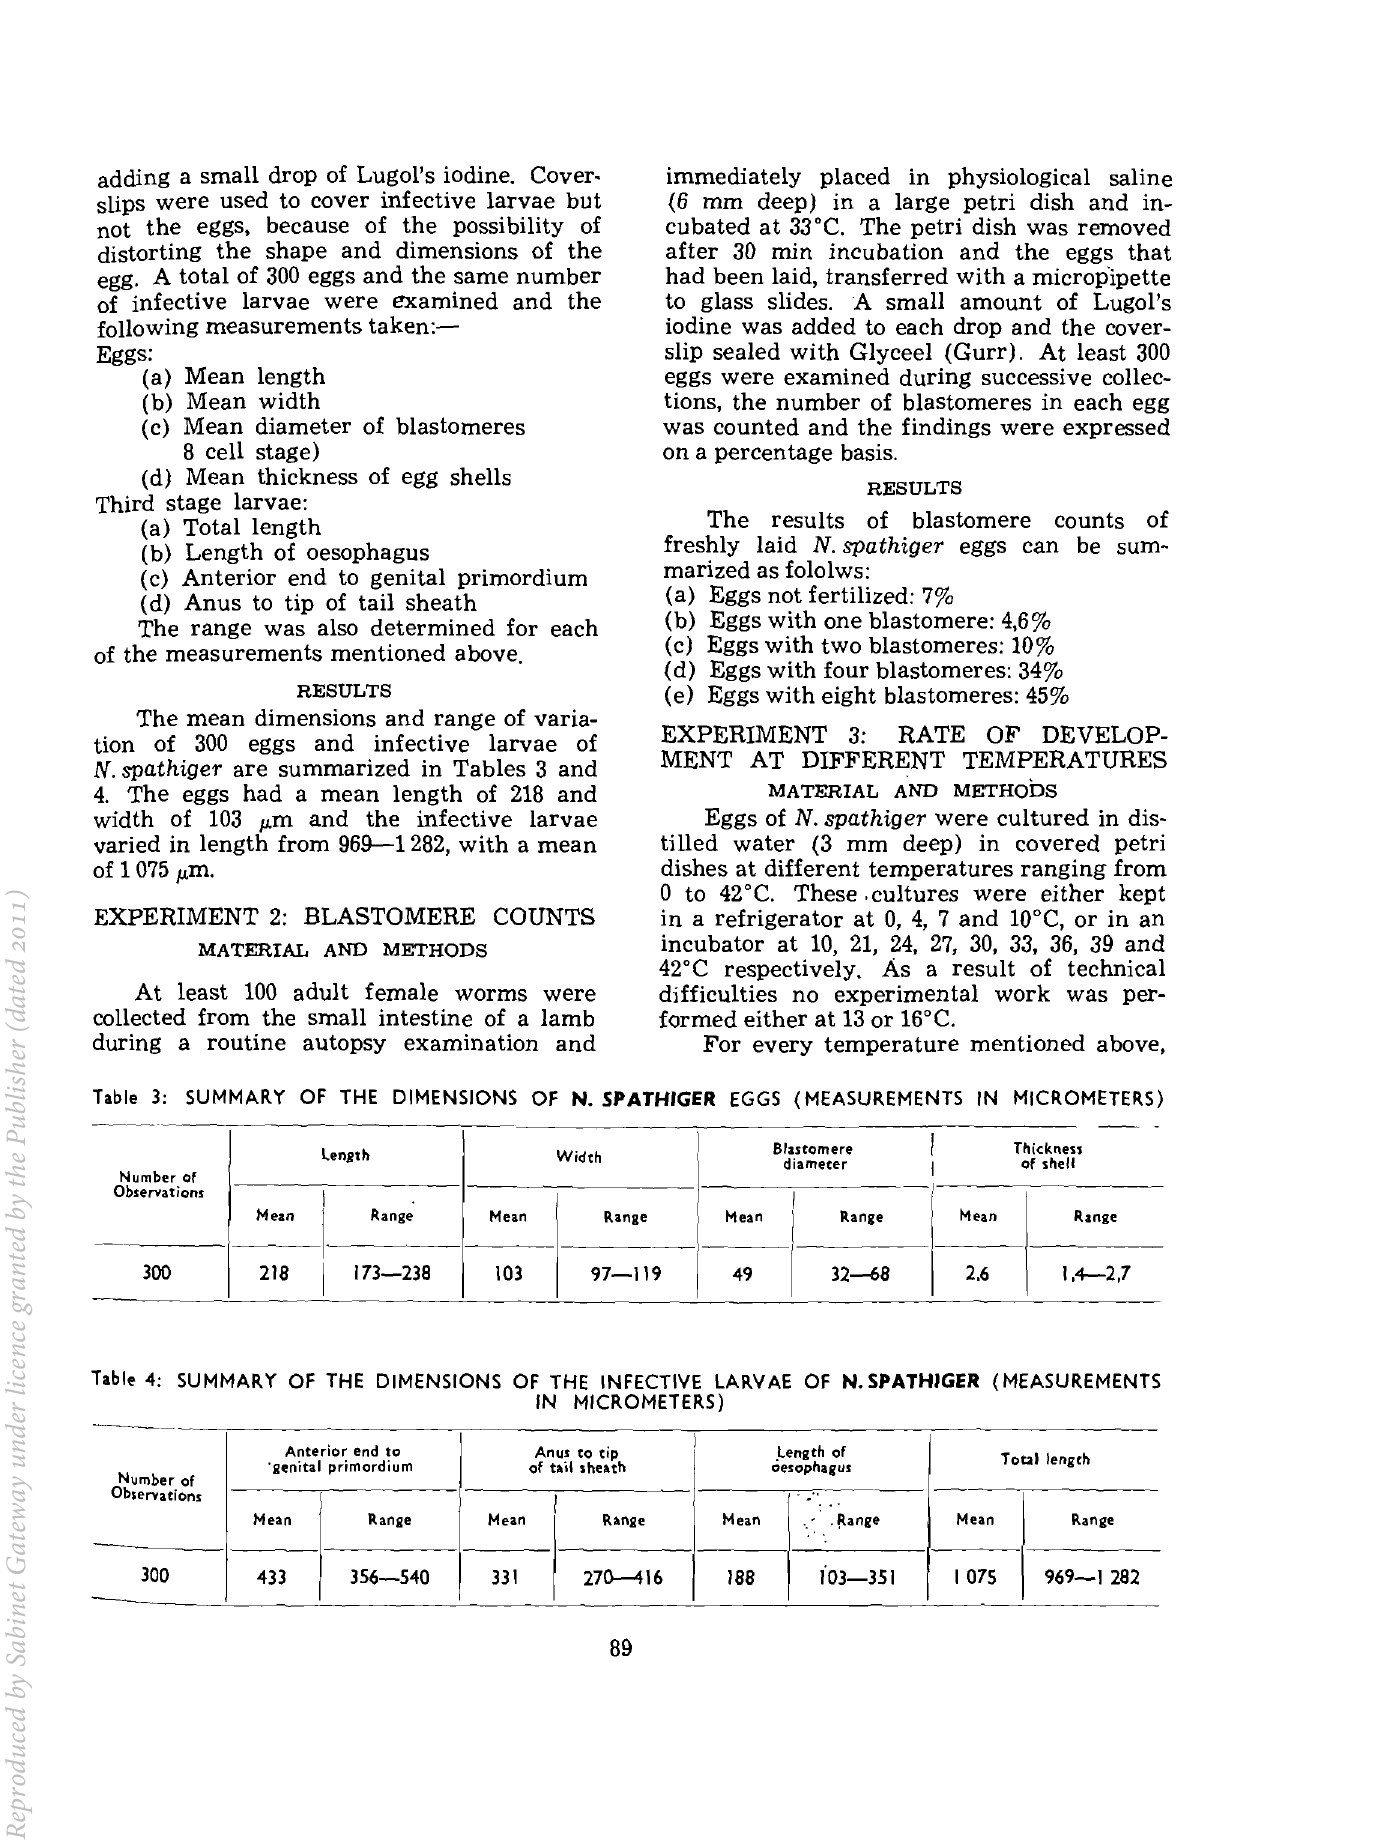
Table 4: SUMMARY OF THE DIMENSIONS OF THE INFECTIVE LARVAE OF N. SPATHIGER (MEASUREMENTS Anterior end to Anus to tip '.Qenital primordium of toil .heoch oesophagus Number of